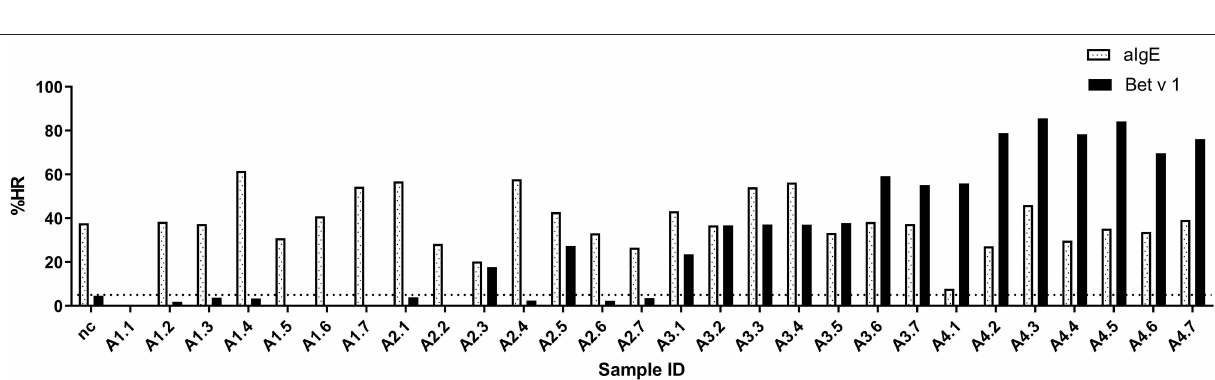
max HR/ED50/CDsens) and reactivity (Ymax/CDmax)